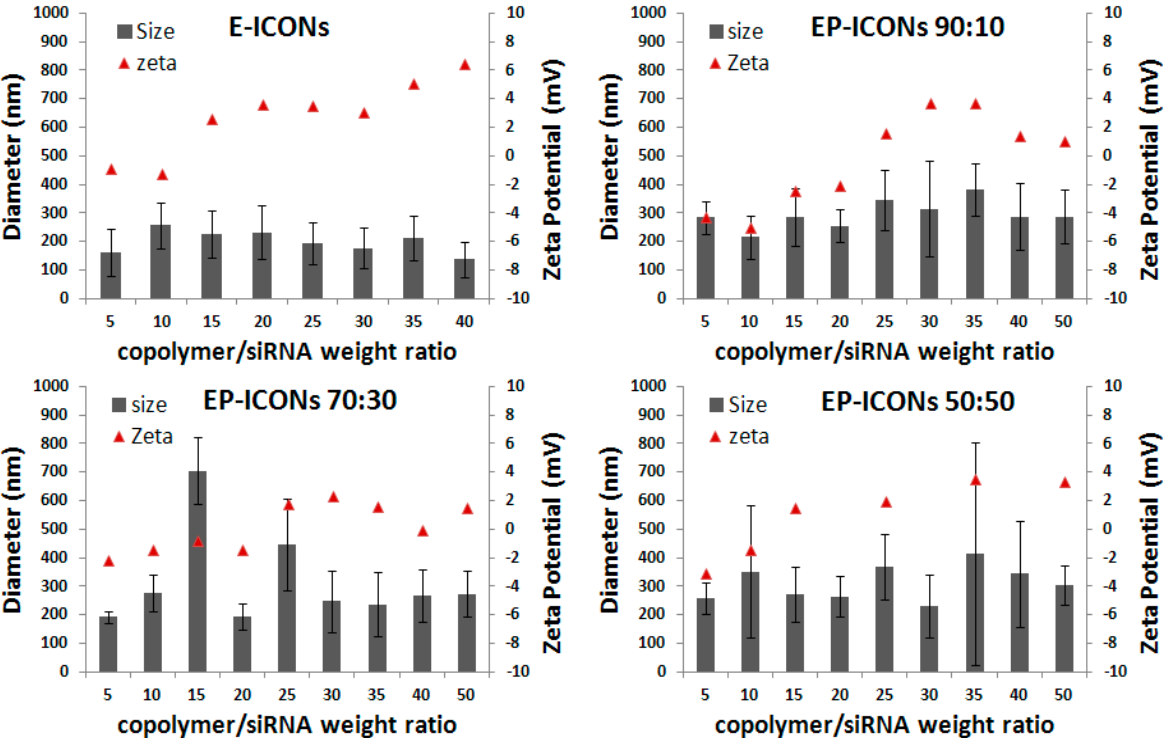
Figure 4. Size and ζ potential values of E-ICONs and EP-ICONs (obtained at INU-IMI-DETA-EGF: INU-IMI-DETA-PEG copolymer weight ratio equal to 90:10, 70:30, 50:50) at copolymer/siRNA weight ratios (R) ranging between 5 and 50.